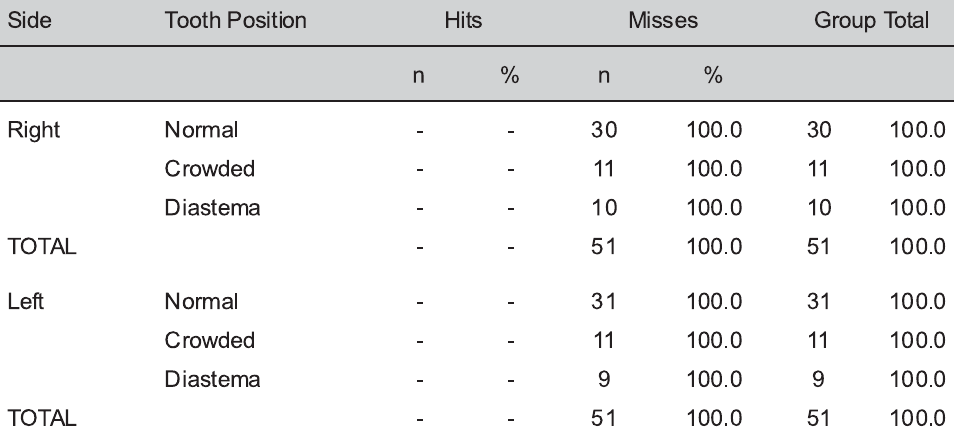
Table 4 - Distribution of hits and misses for normal tooth position, crowded teeth and